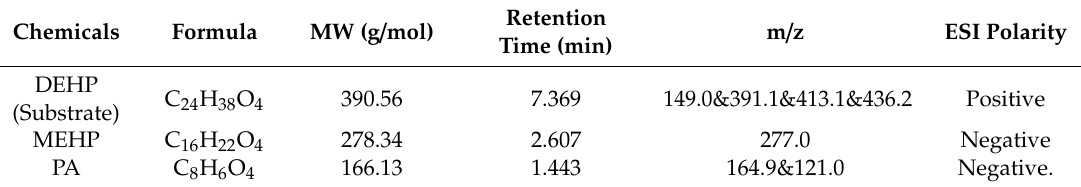
Table 1. Identification of DEHP biodegradation metabolites.